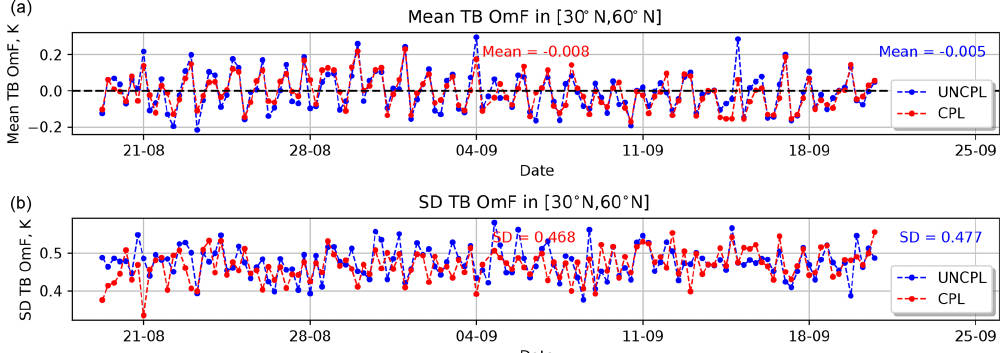
Figure 5. Observation-minus-forecast (OmF) statistics: mean (a) and standard deviation (b) using 6h forecasts. Mean and standard deviation for the brightness temperature (K) as seen by the AQUA AIRS channel 950. The statistics are computed for UNCPL (blue) and CPL (red) in the northern extratropics region between 30 and 60 ◦